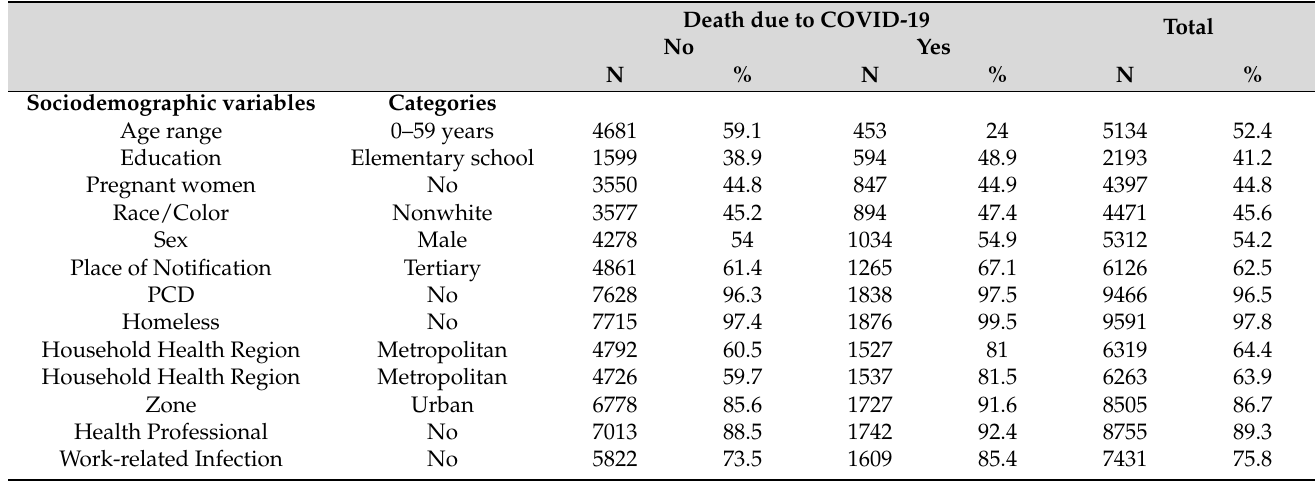
Table 1. Sociodemographic and clinical characterization of hospitalized patients with COVID-19